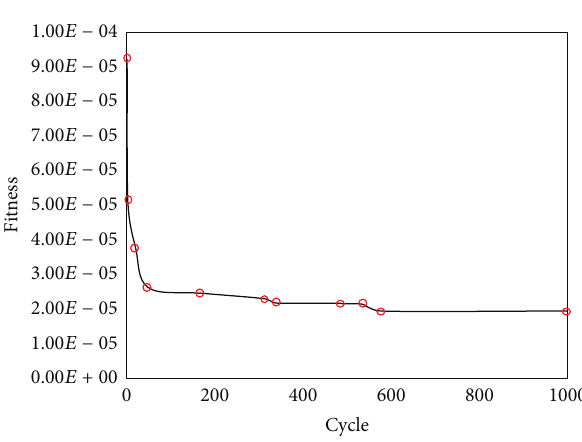
Figure 6: Relationship between fitness value and